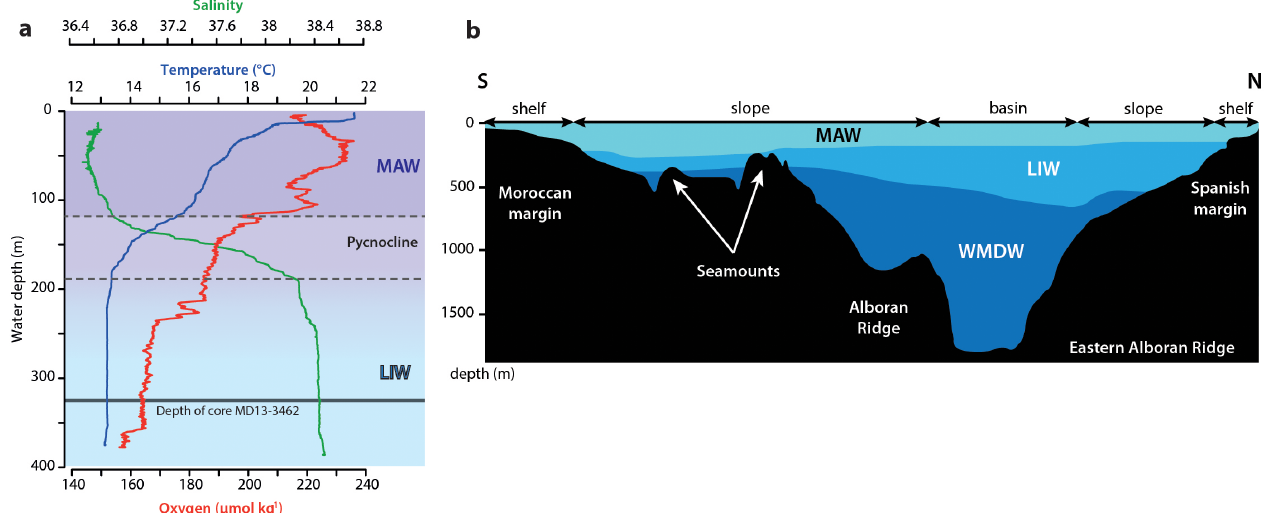
Figure 2. (a) CTD profile taken at the east of Brittlestar Ridge I (35 ◦ 26.087 (cid:48) N; 2 ◦ 30.100 (cid:48) W) during the cruise GATEWAY (no. 194) on board the research vessel Marion Dufresne II in June 2013 (Van Rooij et al., 2017). Salinity (PSU), temperature ( ◦ C), and oxygen content (µmolkg − 1 ) are indicated. The location of core MD13-3462G in relation to the profile is indicated by the black line. (b) North–south- orientated bottom-water profile of the eastern Alboran Sea modified from Ercilla et al. (2016). Abbreviations: MAW – Modified Atlantic Water, LIW – Levantine Intermediate Water, WMDW – Western Mediterranean Dense